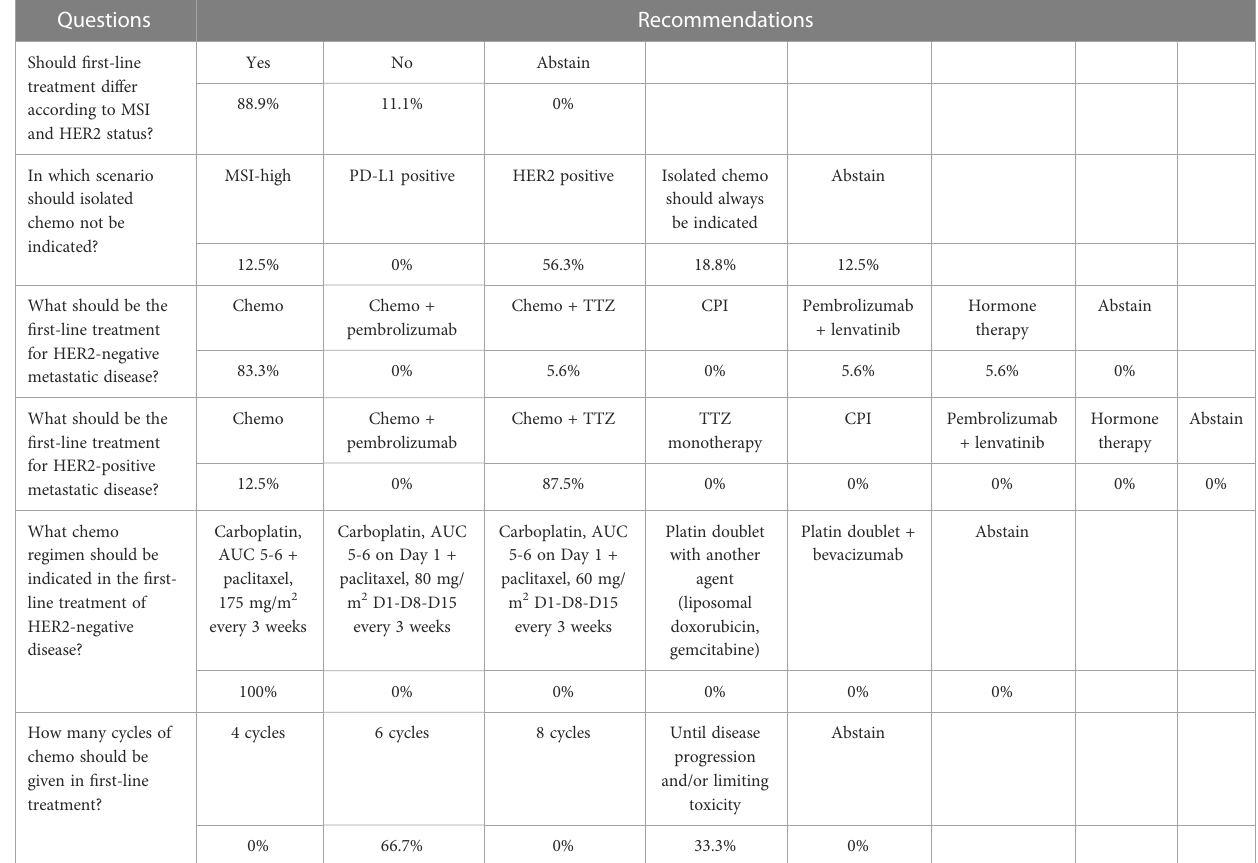
TABLE 2 Questions related to fi rst-line